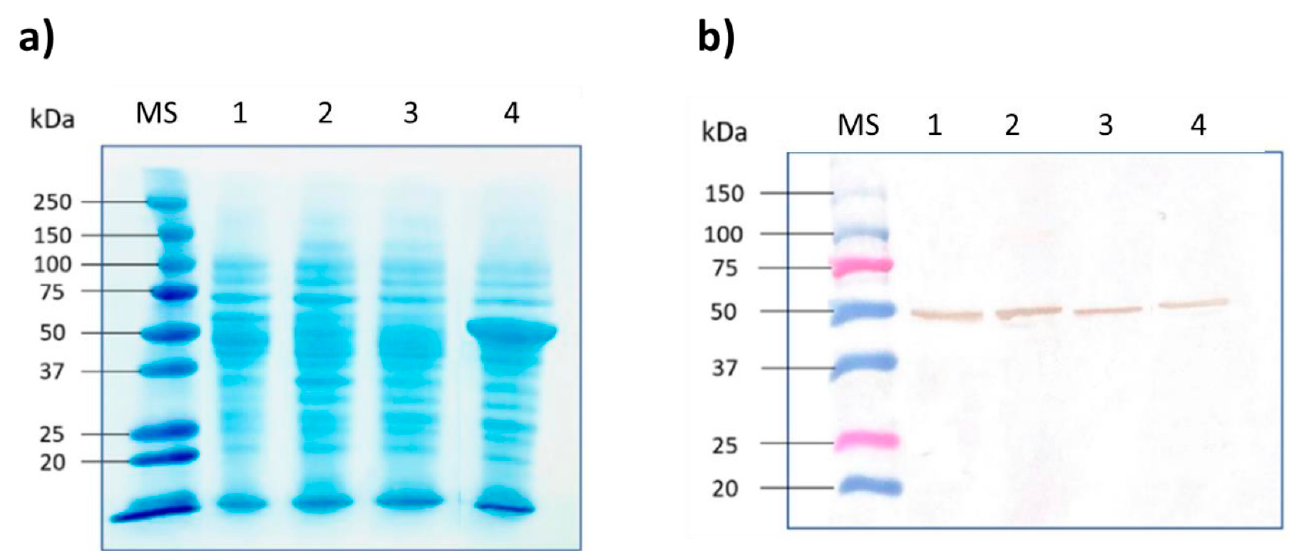
Figure 3. SDS–PAGE (12% acrylamide) analysis of proteins from the soluble fraction of cell lysate. The proteins (15 µg for ( a ) and 0.5 µg for ( b )) were separated by electrophoresis then ( a ) stained by EZBlue gel staining reagent or ( b ) blotted and probed with the specific monoclonal peroxidase conjugated anti-His antibody; MS: molecular mass standard (Precision Plus protein dual-color standard, Bio-Rad, Hercules, CA, USA). Lanes 1 to 4 relate to expression, respectively, with M30, I30, B19 and A19 expression systems.